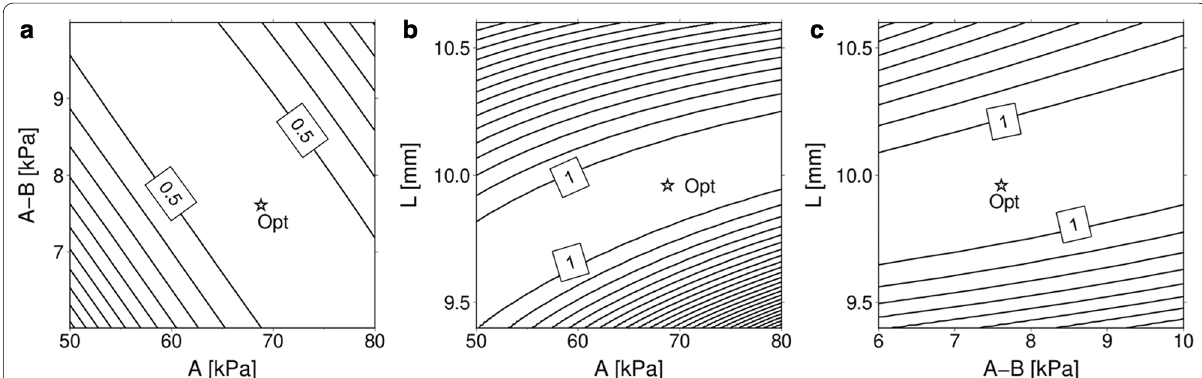
Fig. 6 Two-dimensional contour maps of the cost function for region 5 in Exp. 1. Cost functions are calculated as functions of a ( A 5 , A 5 – B 5 ), b ( A 5 , L 5 ) and c (